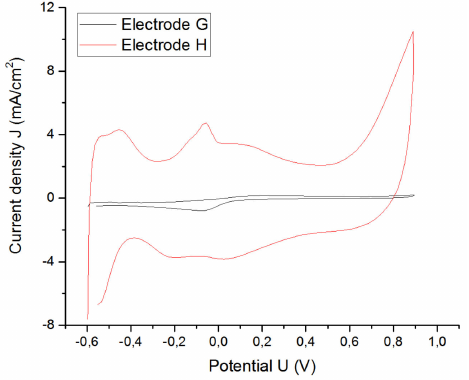
Figure 9. Increase of the delivered charge because of a higher roughness factor for a pulse width of 200 µ s.